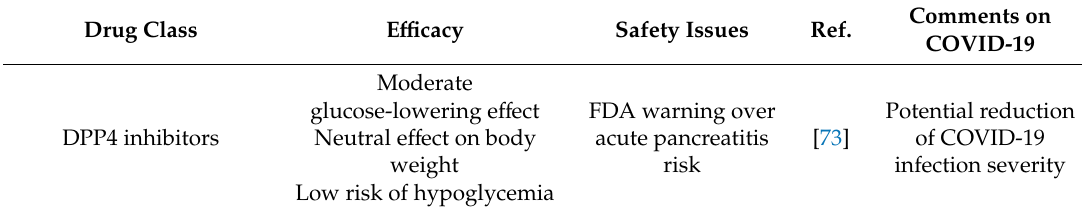
Table 1. Summary of e ffi cacy and safety concerns of novel antidiabetic drug